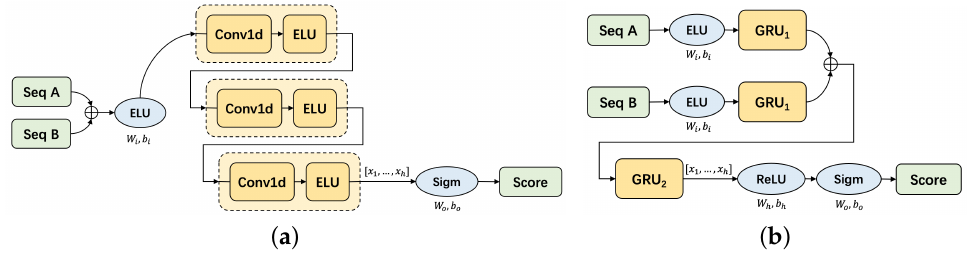
Figure 5. Composition of GCE-Scorer. ( a ) CNN-based scoring model. ( b ) GRU-based scoring